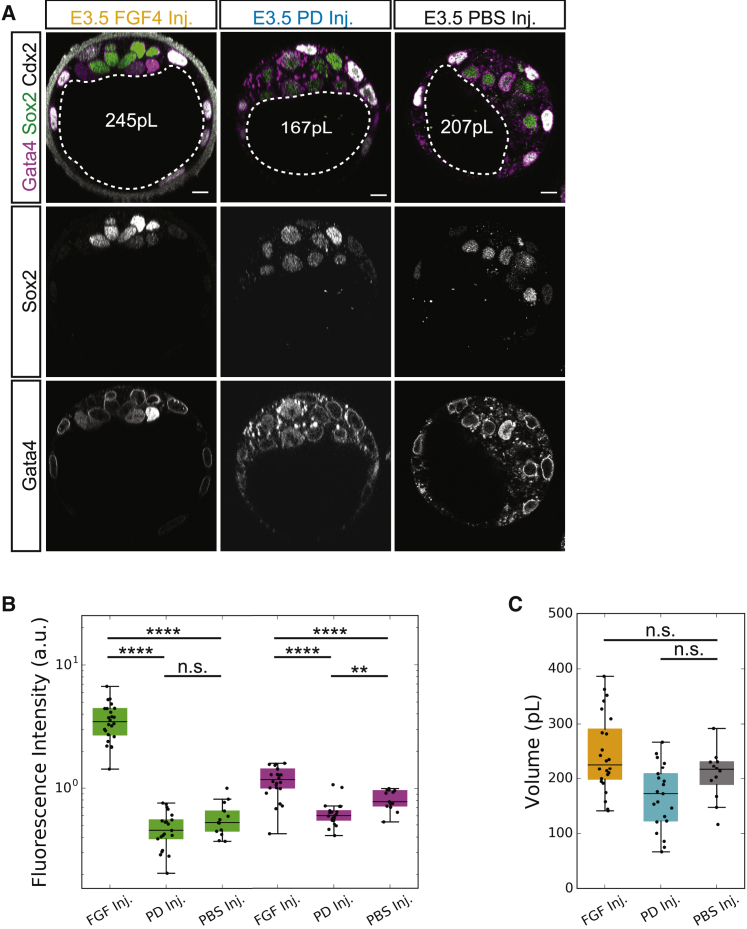
Perturbation of FGF4 Signaling in the Lumen Impacts Molecular Specification of EPI and PrE Lineages(A) Immunofluorescence images of EPI (Sox2) and PrE (Gata4) fate in E3.5 post-FGF4 deposition (E3.5 FGF4 Inj.), E3.5 post-PD173074 deposition (E3.5 PD Inj.), and E3.5 post-PBS deposition (E3.5 PBS Inj.). White dotted line indicates lumen boundaries. Average lumen volume in white text. Scale bars, 10 μm.(B) Boxplot of fluorescence levels of Sox2 (green) and Gata4 (magenta) in E3.5 post-FGF4 deposition (FGF4 Inj., N = 24), E3.5 post-PD173074 deposition (PD Inj., N = 21), and E3.5 post-PBS deposition (PBS Inj., N = 13) embryos.(C) Boxplot of luminal volume in E3.5 post-FGF4 deposition (FGF4 Inj., N = 24), E3.5 post-PD173074 deposition (PD Inj., N = 21), and E3.5 post-PBS deposition (PBS Inj., N = 13).∗∗∗∗p < 0.0001, ∗∗p < 0.01. n.s., not significant.For boxplots: central mark indicates the median; lower edge, 25%; upper edge, 75%; lower whisker, Q1 − (1.5 × IQR) where IQR = Q3 − Q1; upper whisker, Q3 + (1.5 × IQR).See also Figure S7.